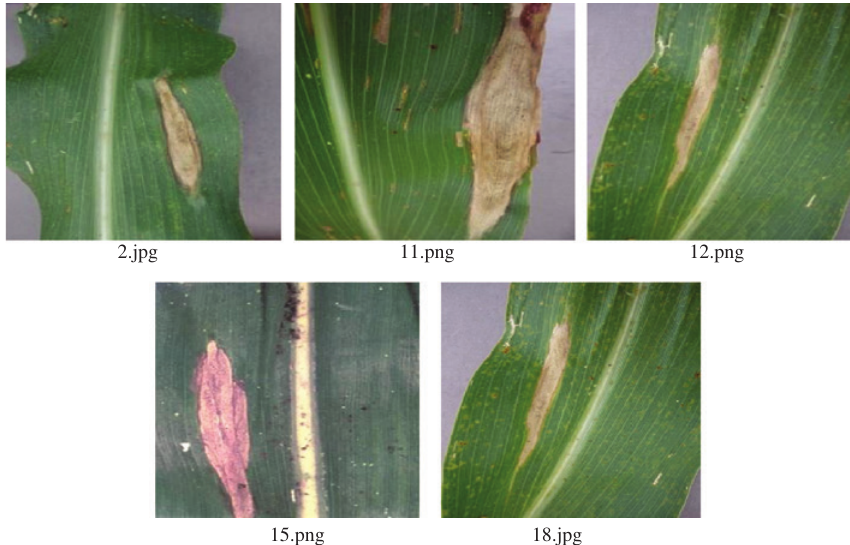
Figure 3: Input Images of Agricultural Plant Corn (maize) from the